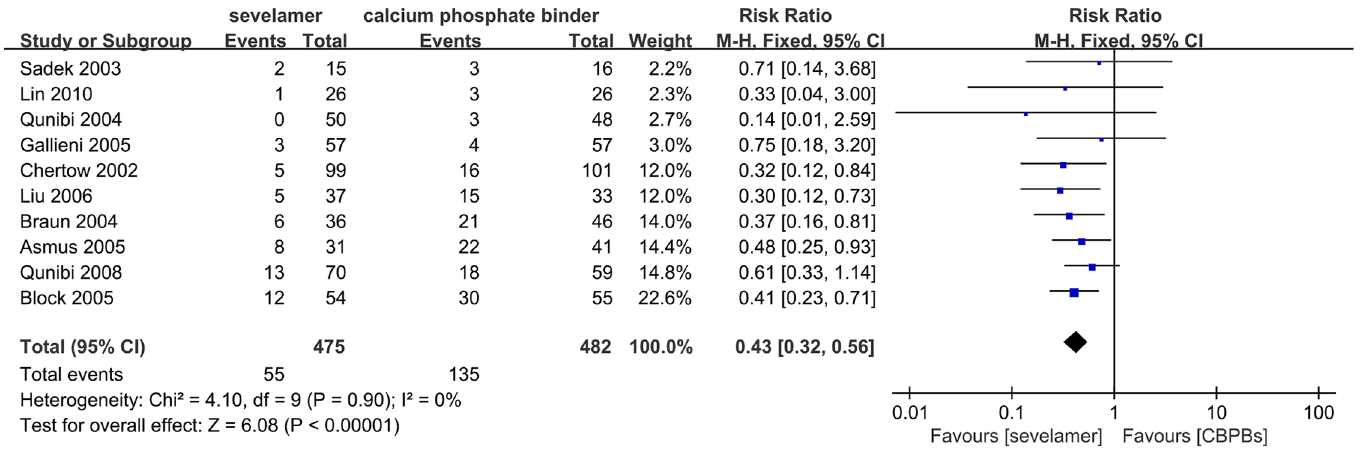
Fig 3. Forest plot of the values of hepercalcemia (above 10.2